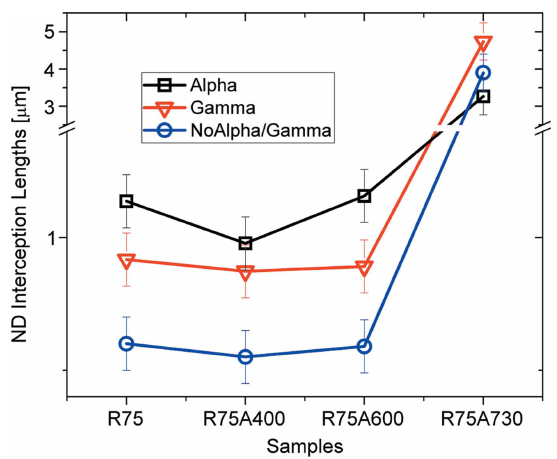
Figure 19 Average intercept lengths along the ND direction for each partition and each sample. For grain size, the (cid:7) -fibre grows larger grains in both the cold-rolled sample and the samples annealed at 400 (cid:6) C and 600 (cid:6) C. Also, the grain size becomes quite homogeneous for the sample annealed at 730 (cid:6) C. All these results are also in agreement with those obtained from XRD analysis.